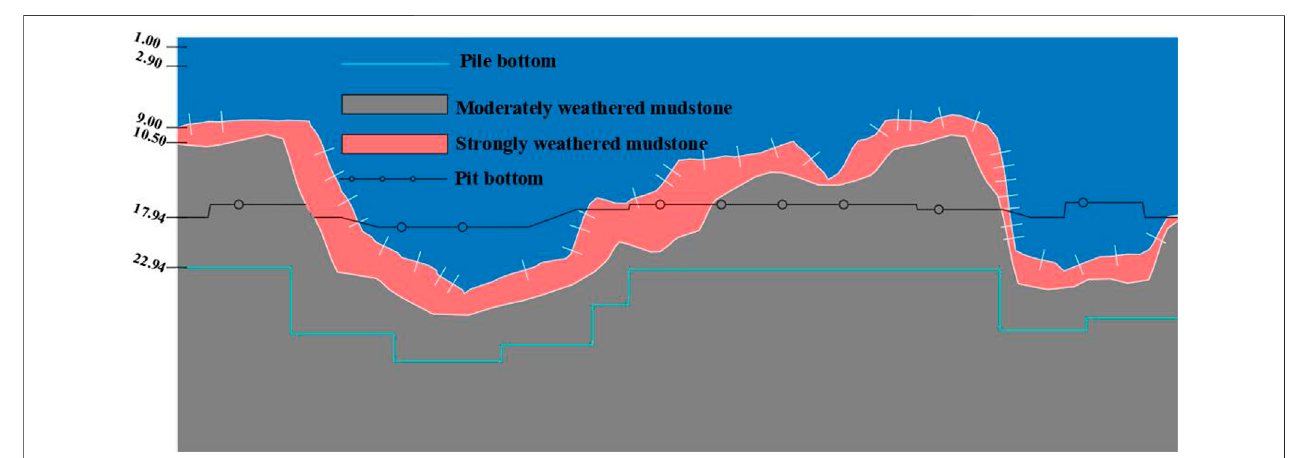
FIGURE 2 | Geological pro fi le of Xishanqiao station (left side).